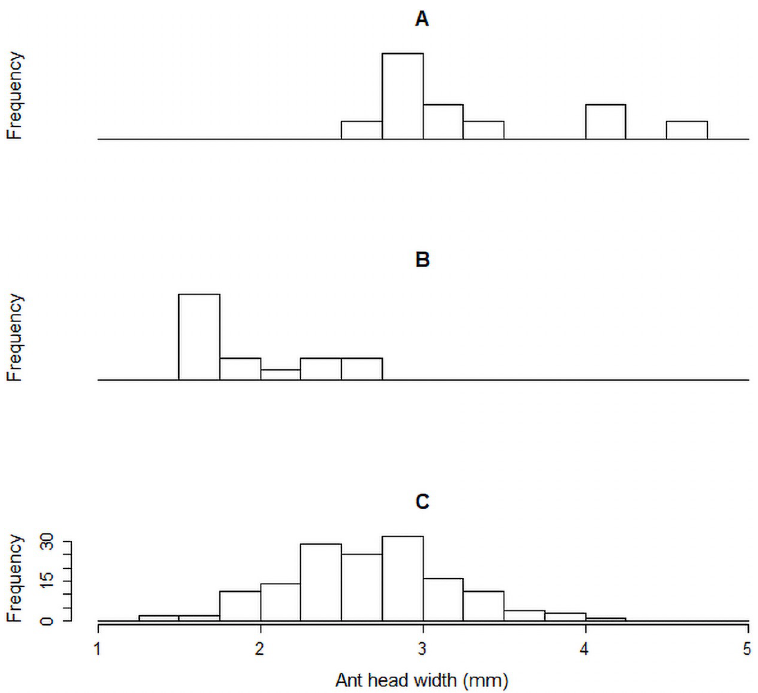
Fig 4. Atta laevigata excavator workers size (head capsule width) in relation to frequency of the two species of phorids parasitizing this caste. A : Eibesfeldtphora erthali (n = 10); B : Myrmosicarius grandicornis (n = 15); C : Size range of excavators (n = 150) collected on the mounds of loose soil near the